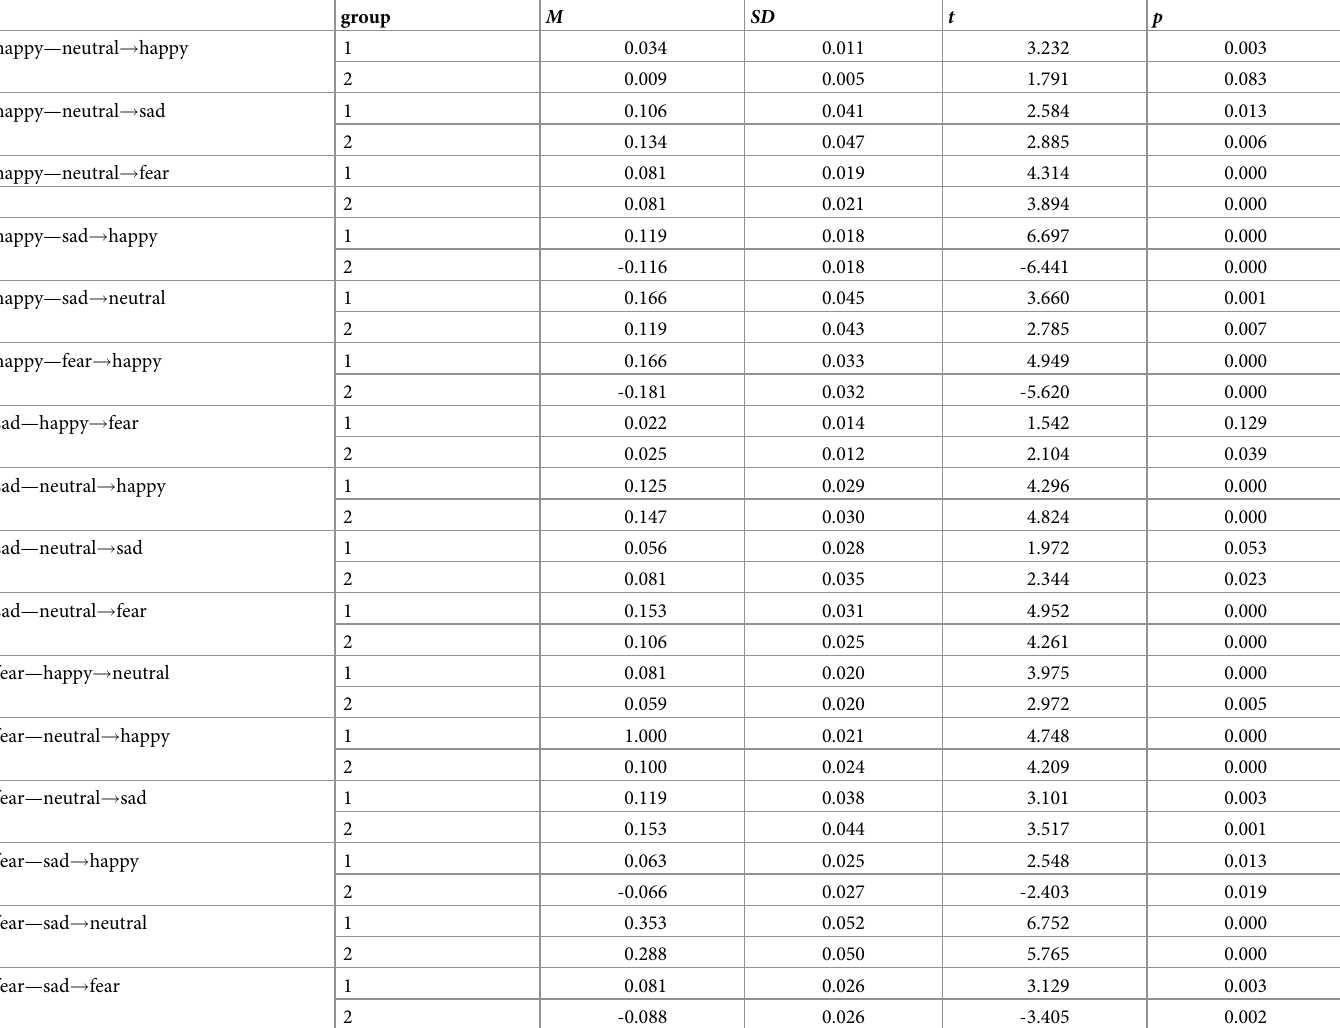
Table 2. The results of independent sample t-test of experimental and control groups’ misjudgment ( df = 62).